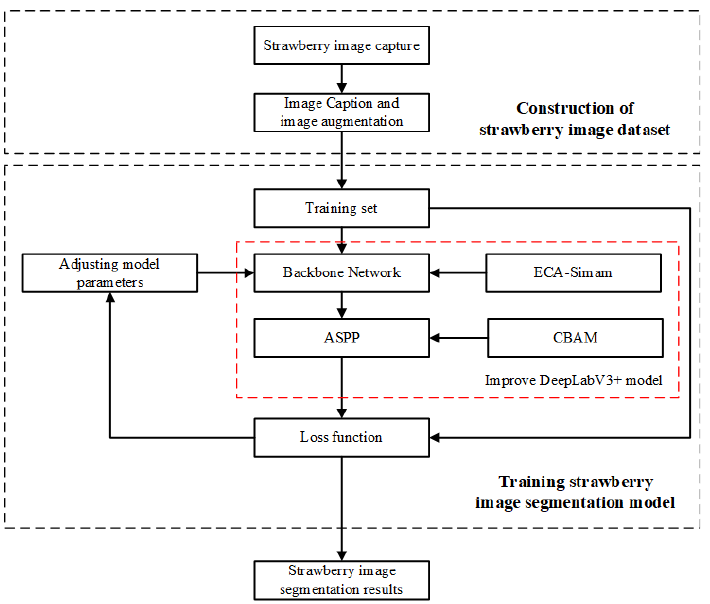
Figure 1. Overall workflow diagram.